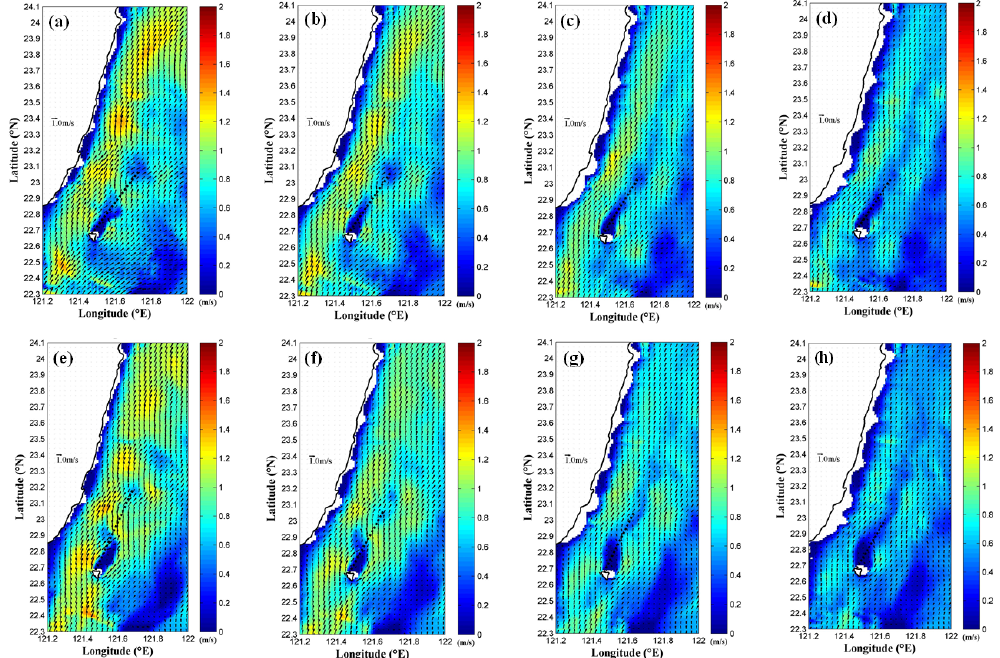
Figure 17. The velocity fields at water depths of ( a , e ) 20, ( b , f ) 50, ( c , g ) 100, and ( d , h ) 150 m of the numerical results obtained by ( a – d ) constant SW and ( e – h ) NE wind conditions.